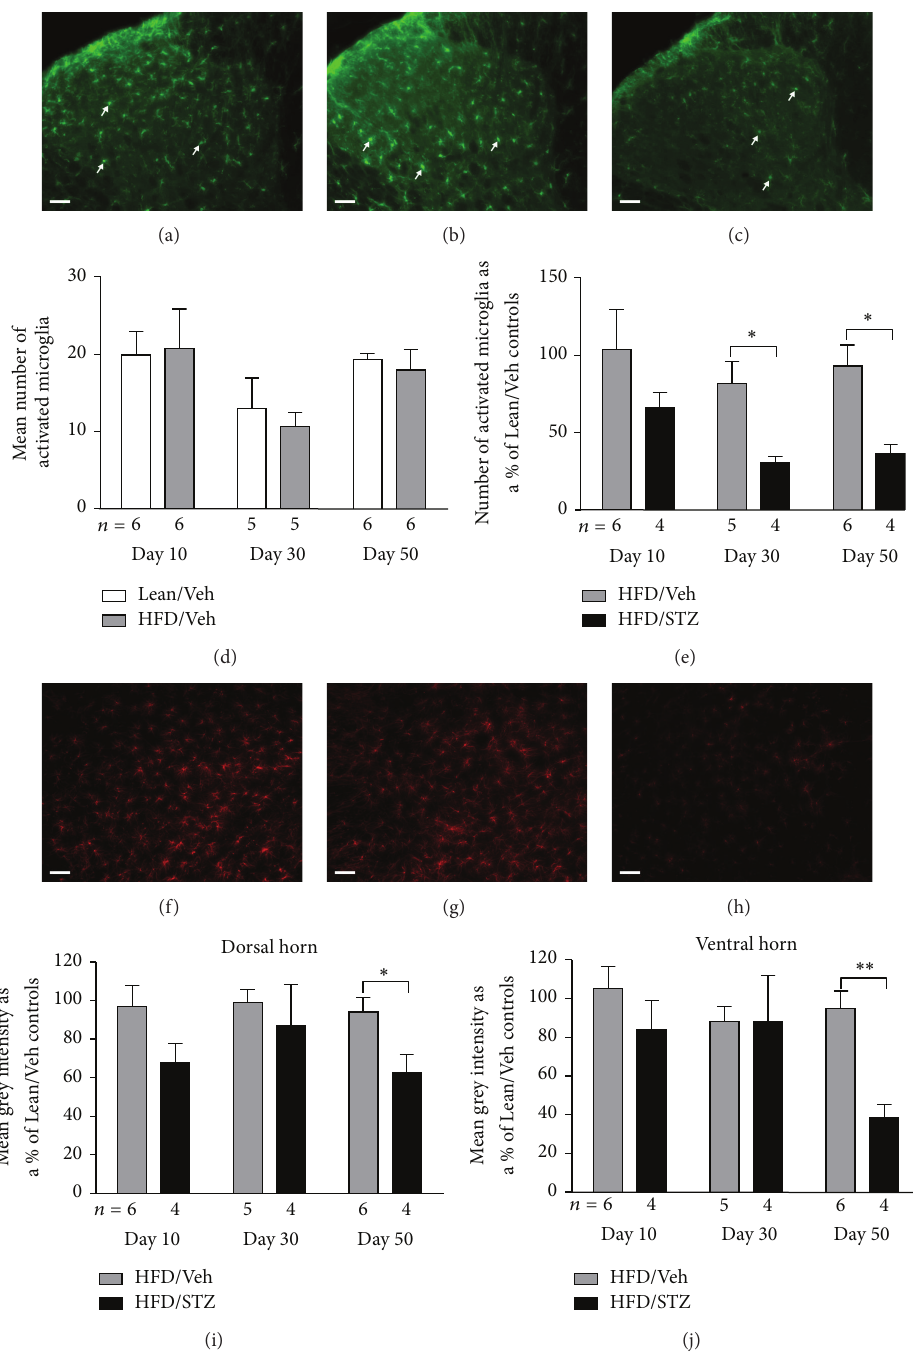
Figure 4: Effects of the HFD/STZ model on Iba-1 and GFAP staining in the spinal cord. ((a)–(c)) Representative images of Iba-1 staining in the dorsal horn of the spinal cord in a Lean/Veh, HFD/Veh, and HFD/STZ rat, from left to right. Scale bar: 50 𝜇 m (20x magnification). Arrows indicate examples of Iba-1 positive cells morphologically identified as activated microglia. (d) Numbers of Iba-1 positive cells morphologically identified as activated microglia in the dorsal horn of the control groups (lean/vehicle and HFD/vehicle). (e) Effects of HFD/STZ on number of Iba-1 positive cells morphologically identified as activated microglia in the dorsal horn expressed as a percentage of the number in the Lean/Veh control group. The numbers of rats per group are shown below the 𝑥 -axis, and 7 spinal cord sections per rat were processed. Data are mean ± SEM. Analysis was by a Mann-Whitney test: ∗ 𝑃 < 0.05 . ((f)–(h)) Representative images of GFAP staining in the ventral horn of the spinal cord in a Lean/Veh, HFD/Veh, and HFD/STZ rat, from left to right. Scale bar: 50 𝜇 m (20x magnification). Effects of HFD/STZ on mean grey intensity of spinal GFAP immunofluorescence in (i) the dorsal horn and (j) the ventral horn, expressed as a percentage of the mean grey intensity in the Lean/Veh control group. The number of rats per group is shown below the 𝑥 -axis, and 7 spinal cord sections per rat were processed. Data are mean ± SEM, analysis was by a Mann-Whitney test: ∗ 𝑃 < 0.05 , ∗∗ 𝑃 < 0.01